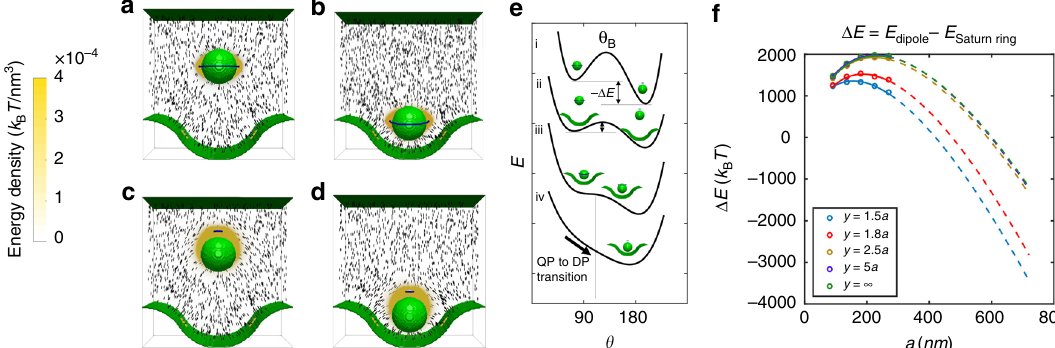
Fig. 5 Simulated energy density for dipole and quadrupole near a wavy boundary. By exploring the energy for colloids in dipole (DP) and Saturn ring (QP) con fi gurations at various positions above the well for fi xed colloid size and wavy wall geometry, the equilibrium heights for the Saturn ring are found. a A Saturn ring located at the reference state far from the wall (state 1, y = 5 a ). b A Saturn ring located at its equilibrium location (state 2, y = 1.8 a ), a decrease of 203.5 k B T from state 1. c A dipole located at the reference state far from the wall (state 1, y = 5 a ). d A dipole located at its equilibrium location (state 2, y = 1.5 a ), with an energy decrease of 585.01 k B T from state 1. e Schematic representation of the total energy of the system E vs. the reaction coordinate θ for several distances y from the well, changing from far from the well to close to the well (i through iv) as E decreases. The presence of the well shifts the angle of the energy barrier ’ s maximum to the right (increasing θ ) and decreases the energy barrier until it is eliminated as the particle moves closer to the wall. f The energy of the dipole and quadrupole are calculated for systems of different size (colloid radius a = 90, 135, 180, 225, 270 nm; the simulation box and the walls are scaled accordingly). The energy difference between quadrupole and dipole ( Δ E = E dipole − E Satum ring ) is plotted against a . Circles denote simulation results, solid lines are fi tted to forms suggested by scaling arguments, dotted line are extrapolations based on these fi ts